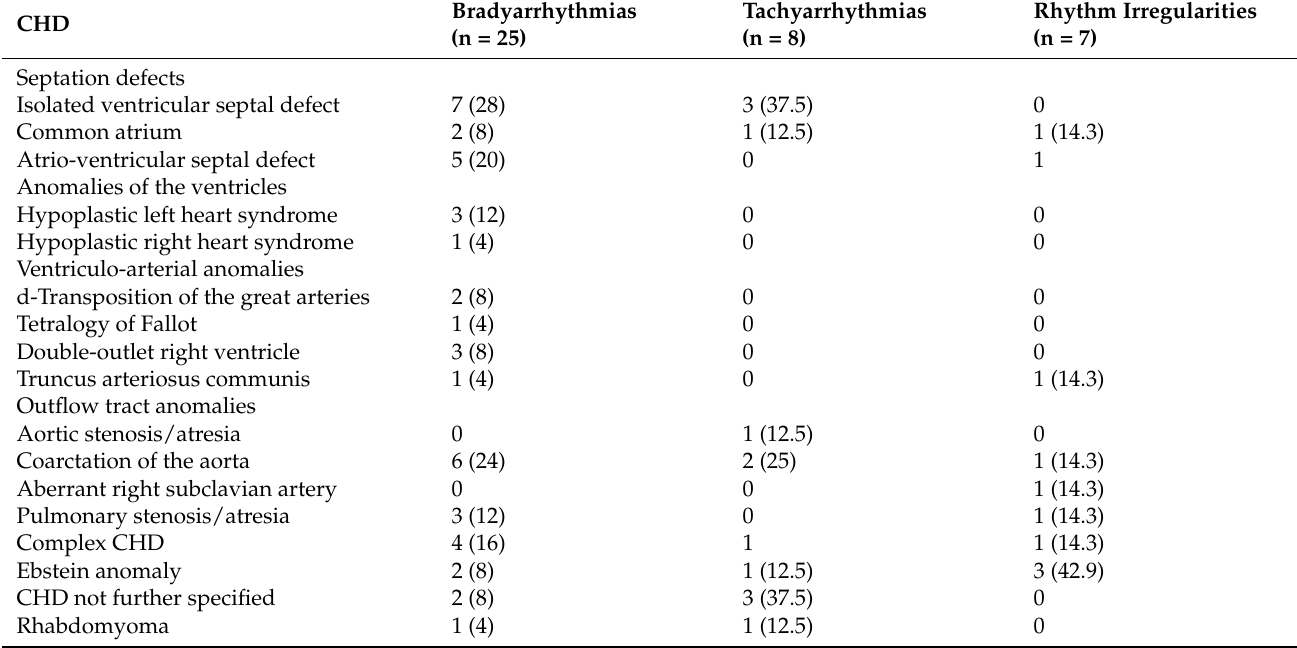
Table 2. Congenital heart disease (CHD) among fetuses with dysrhythmia.